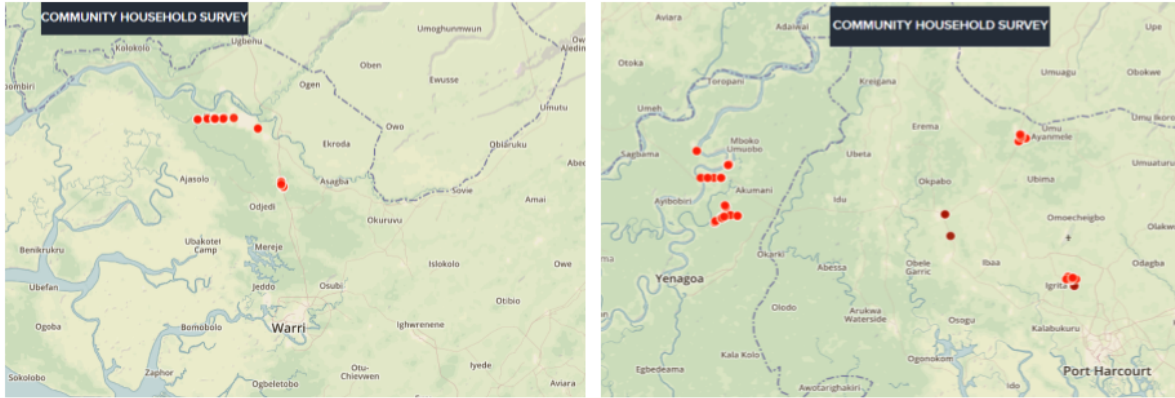
Figure 2. Geomap of all the households across the 6 communities in 3 states of the Niger Delta region of